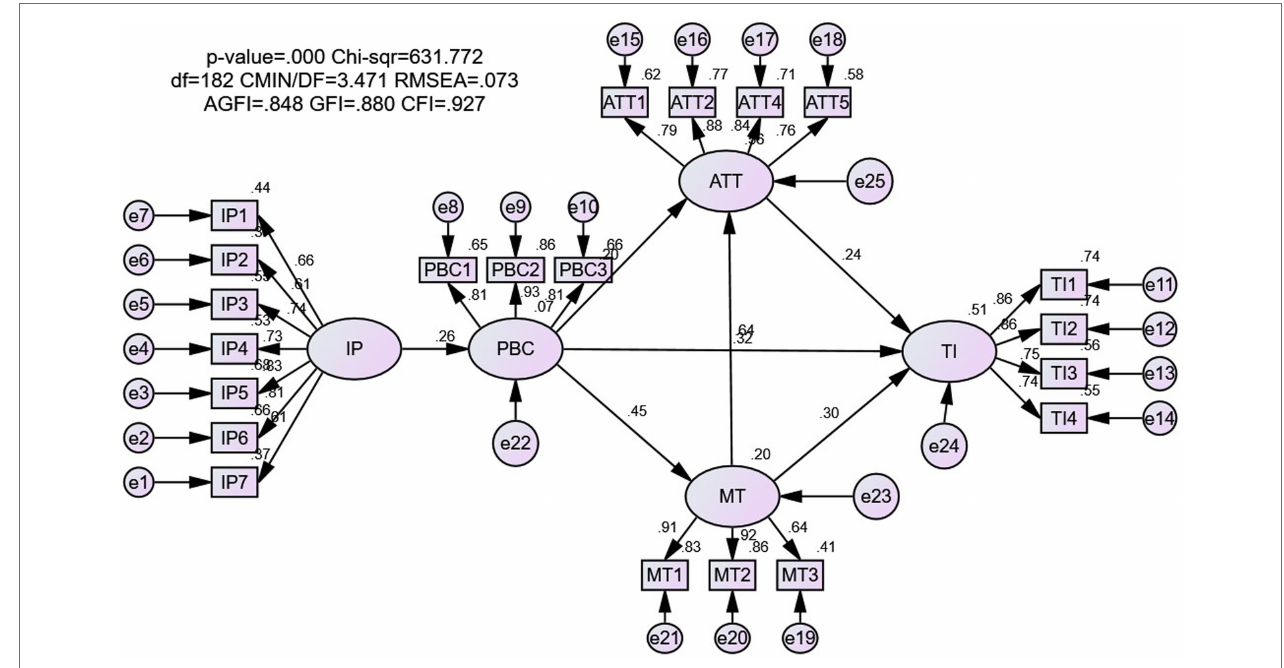
FIGURE 2 | Measurement and structural model analysis.